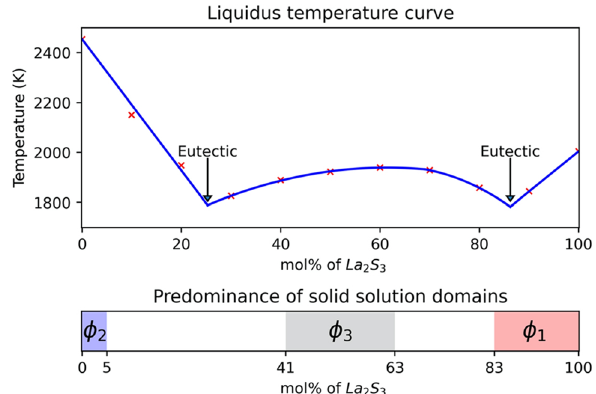
Figure 8. Liquidus temperature for the BaS- La 2 S 3 pseudo binary system and definition of the potential domains of phase stability and proposed eutectic points (25 and 86 mol% of La 2 S 3